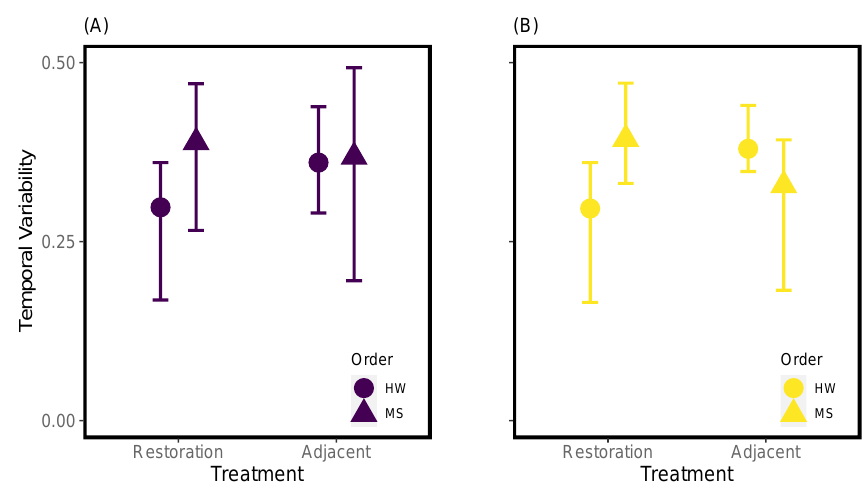
Figure 4 : Plots of temporal variability. Estimates are reported for headwaters (HW, circles) and mainstems (MS, triangles); values from the full sites are reported in purple (A), while those from the revised sites are reported in yellow (B). Points represent mean ± 95%